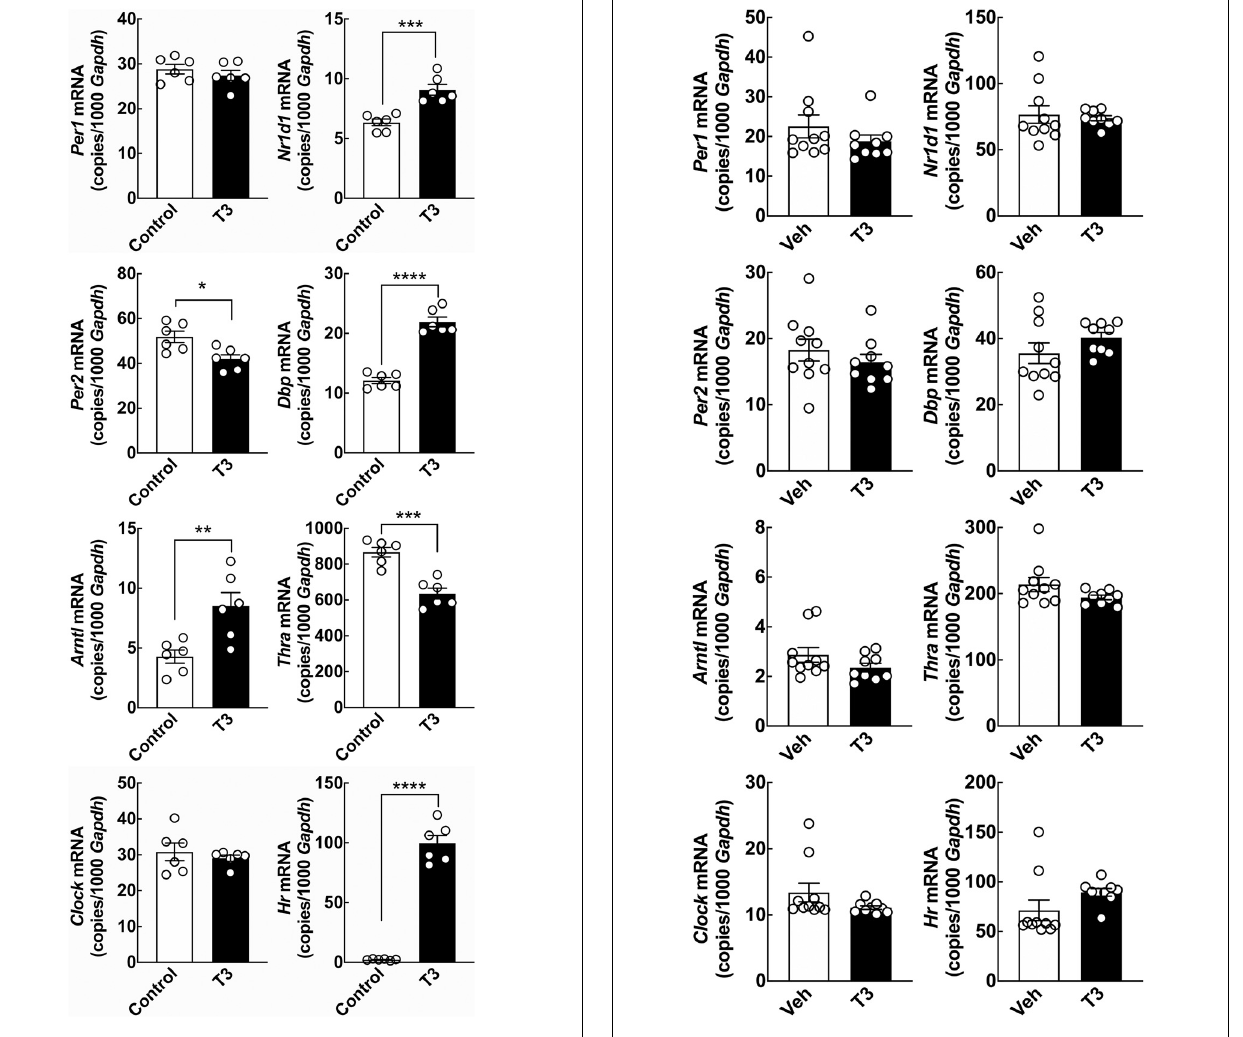
FIGURE 2 | The effect of T3 on clock gene expression in cultured rat cerebellar granule cells determined by qRT-PCR. Cerebellar granule cells were exposed to 0.1 µ M T3 for 12 h and compared to untreated controls. Significant effects on expression levels of the clock genes Per2 , Arntl , Nr1d1, and Dbp were revealed by Student’s t -test. In addition significant effects on the thyroid hormone receptor Thra and the positive control T3-responsive gene Hr were detectable. Analyses of Clock and Hr included Welch’s correction. * p < 0.05; ** p < 0.01; *** p < 0.001; **** p < 0.0001. n = 6.